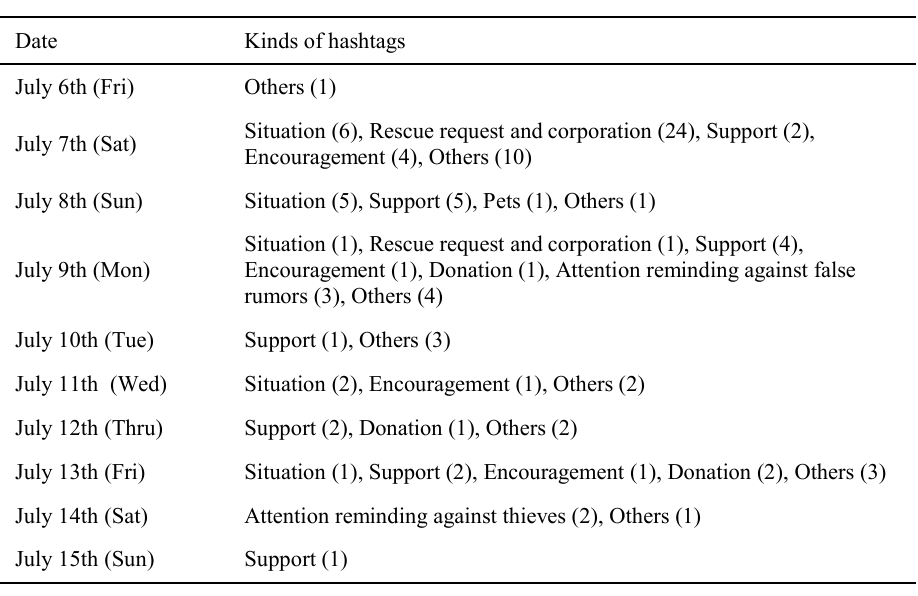
Table 2. Kinds of hashtags related Mabi District, Kurashiki City, Okayama Prefecture (July 16,